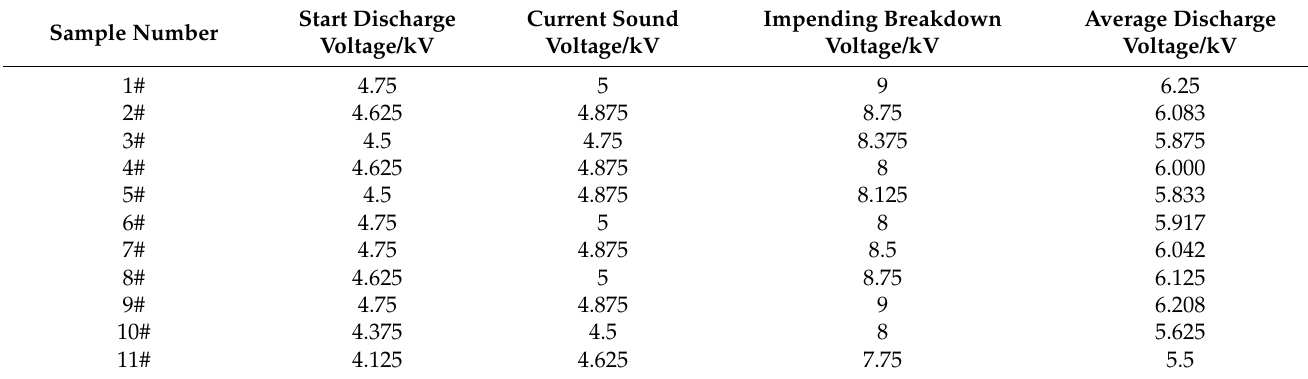
Table 1. Partial discharge voltage data of insulator slice.